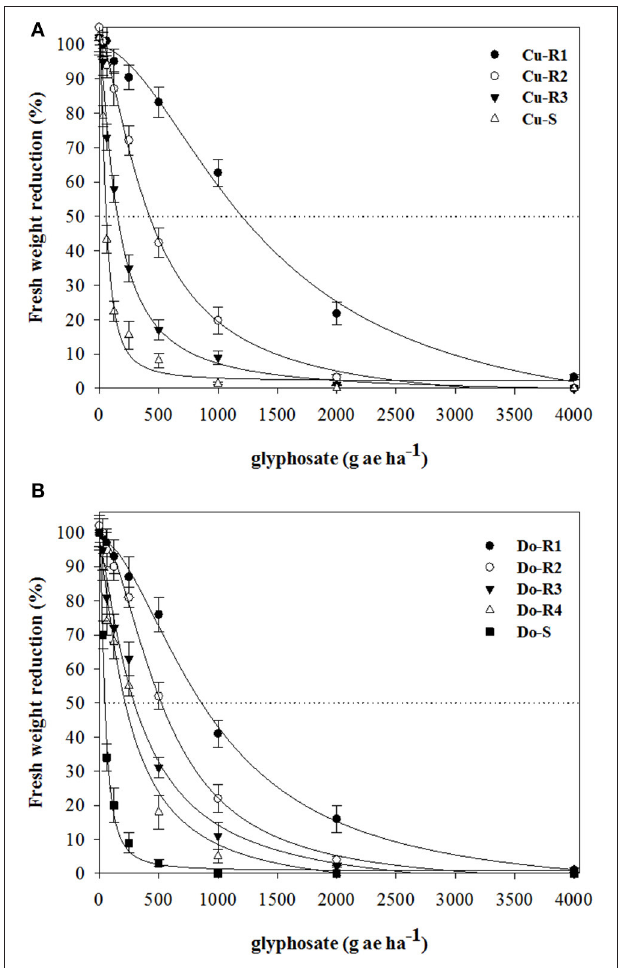
FIGURE 2 | Survival plants in glyphosate-resistant and susceptible P. hystherophorus accessions from Cuba (A) and Dominican Republic (B) 30 days after treatment. Symbols denoted mean ( n = 10) ± standard errors of the